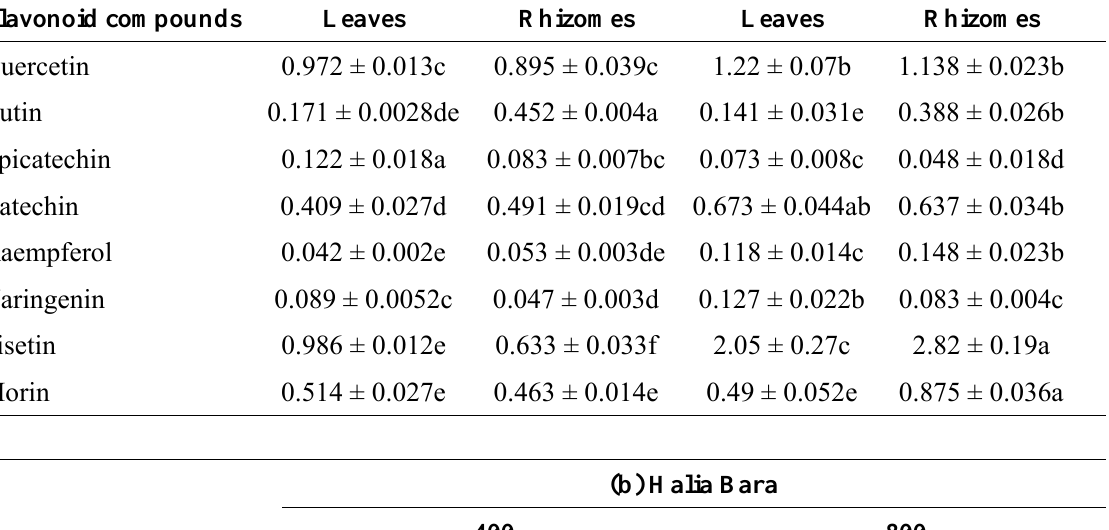
Table 1. The concentrations of some flavonoids compounds in two varieties of Zingiber officinale, Halia Bentong (a) and Halia Bara (b) grown under different CO